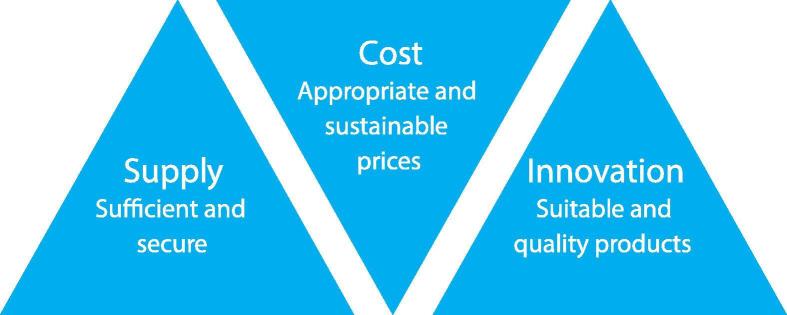
Priorities of the Supply and Procurement Strategy [3].